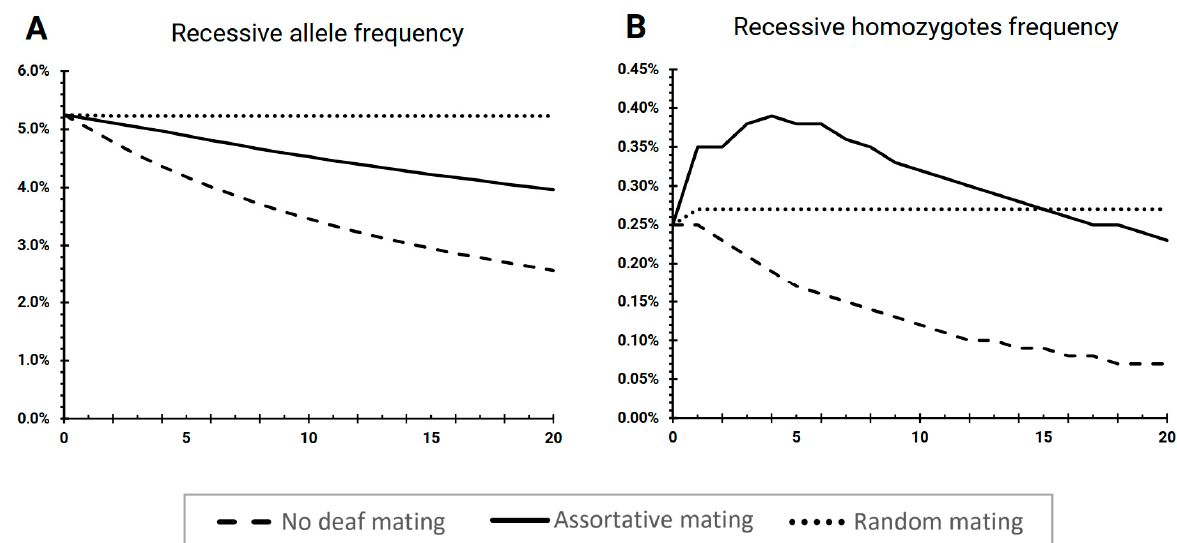
Figure 3. Model outcomes for different scenarios. ( A ) Frequency of recessive mutant allele. ( B) Pro- portion of deaf individuals (recessive mutant homozygotes). Y-axis: proportion, X-axis: generations (1 generation = 20 years).